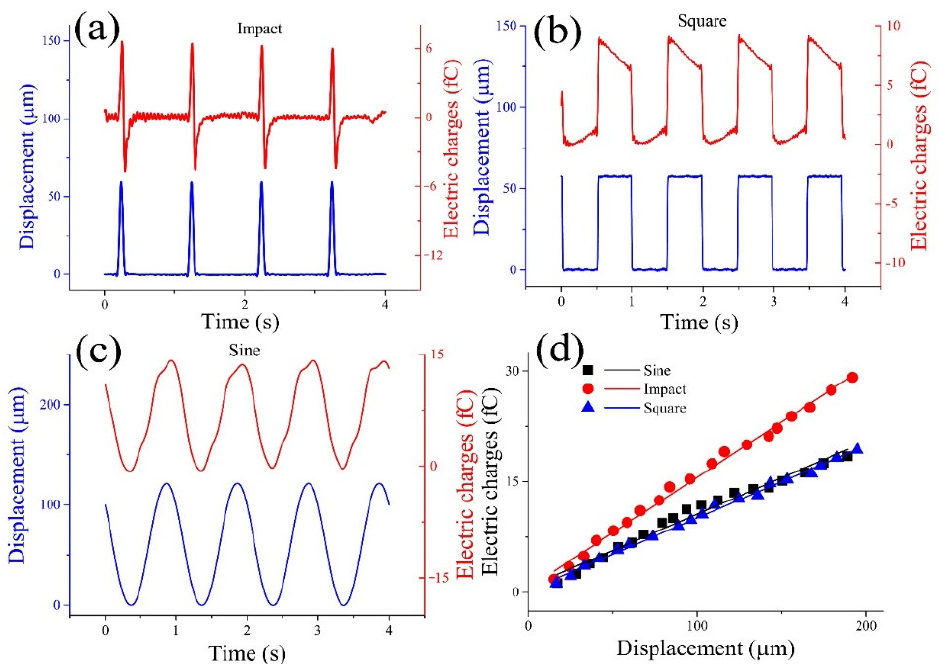
Figure 4. Deformation experiment of the cupula, whereby ( a ) the cupula was separately subject to an impact vibration, ( b ) a square vibration, and ( c ) a sinusoidal vibration. ( d ) The relationship between the amplitude of cupula deformation and the amplitude of output electric charges.